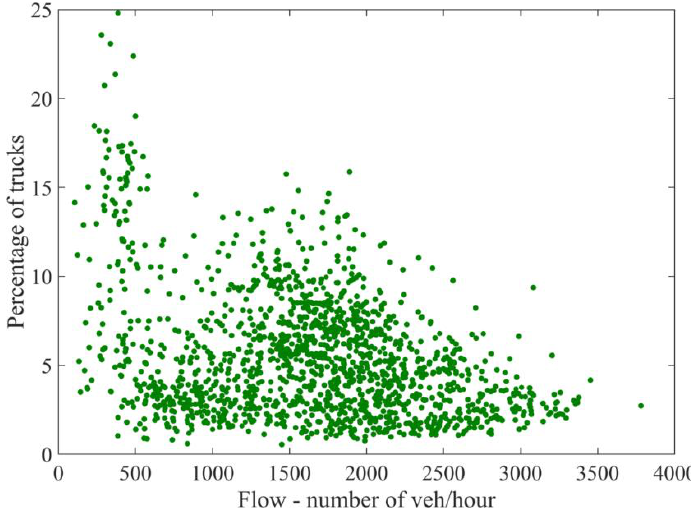
Figure 4. Correlation between traffic flow and percentage of trucks.